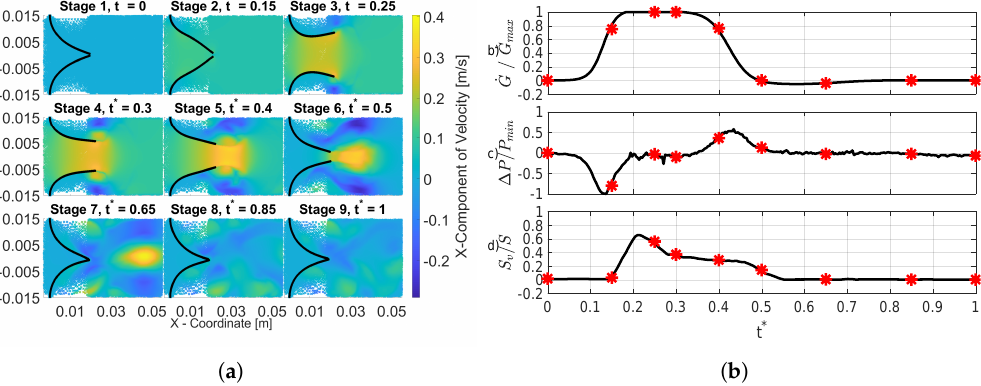
Figure 2. ( a ) Each stage represents the results of different stages of the FSI simulation using U max = 0.0964 m/s, T = 1.5015 s, and E = 2.15 MPa. ( b ) This figure indicates the information (red marks) of the previous nine stages measured for ˙ G , ∆ P, and S v as a function of t ∗ . The maximum values obtained are ˙ G max =0.1446 × 10 − 3 m 3 /s, | P min | =163.697 Pa, and S = 0.03